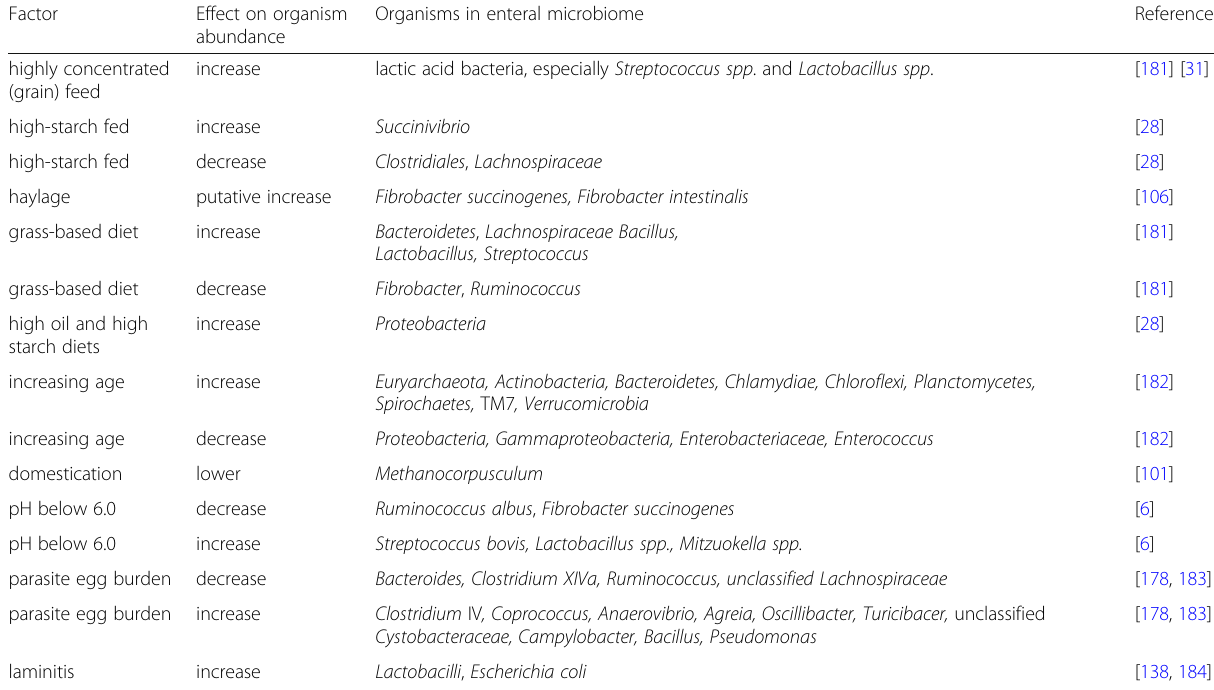
Table 2 Effects of specific factors on equine intestinal organism